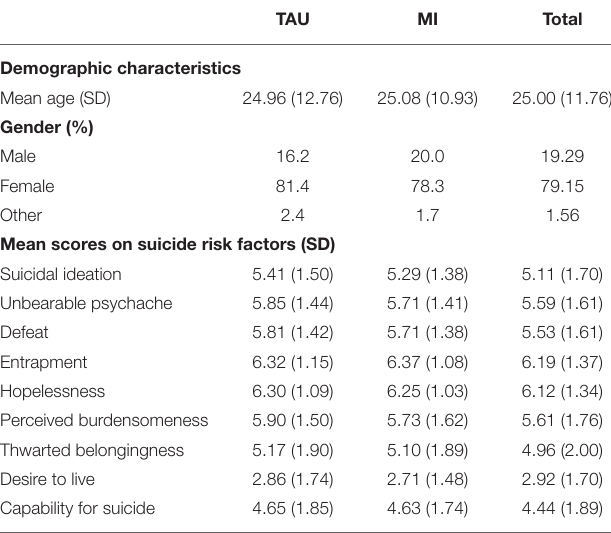
TABLE 2 | Baseline characteristics of the